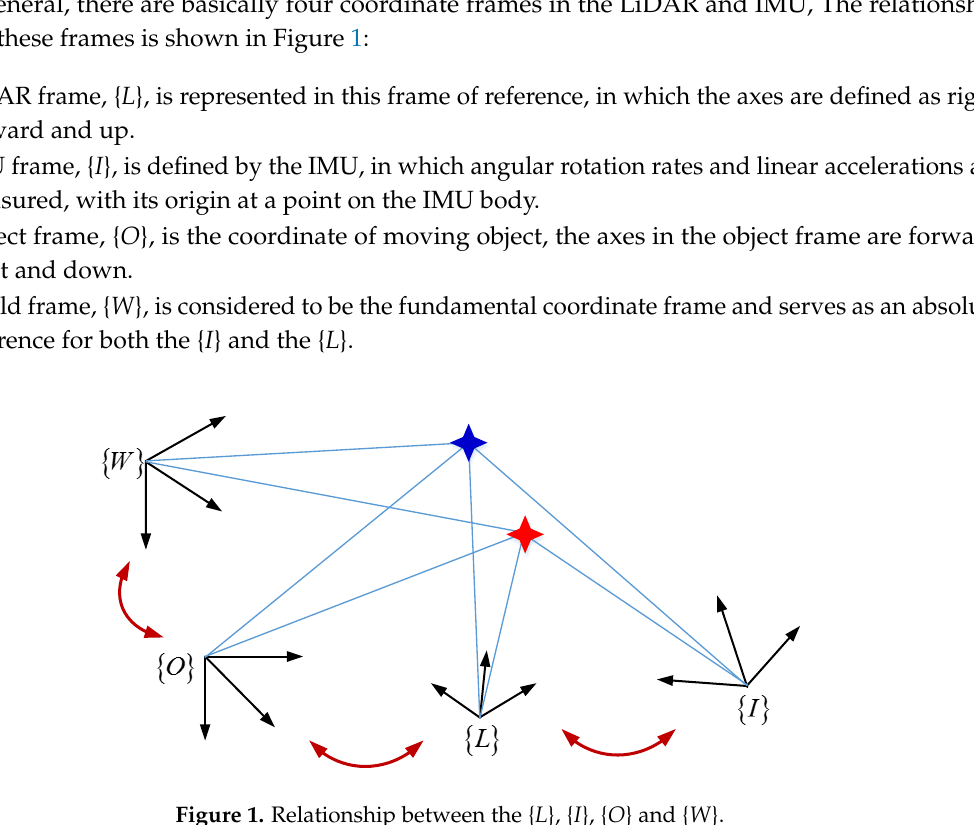
Figure 1. Relationship between the { L }, { I }, { O } and { W }.